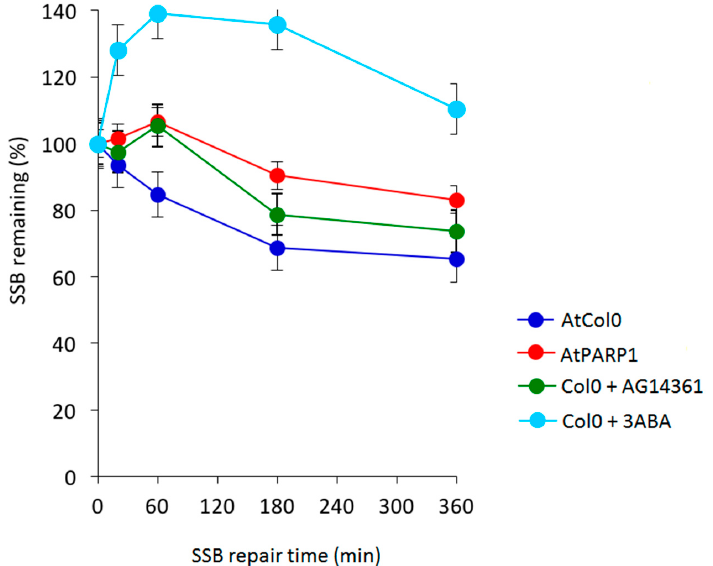
Figure 11. Effect of the knockdown mutation of AtPARP1 and of specific and broad spectrum inhibitors of PARP1 on SSB repair kinetics obtained by an A/N comet assay. SSBs generated following 1 hr treatment with 2 mM MMS (methyl methanesulfonate) in AtPARP1 and in Arabidopsis Col1, in the presence of 3 mM 3-aminobenzamide (3-ABA) and 10 μ M HsPARP1 specific AG14361 inhibitors.